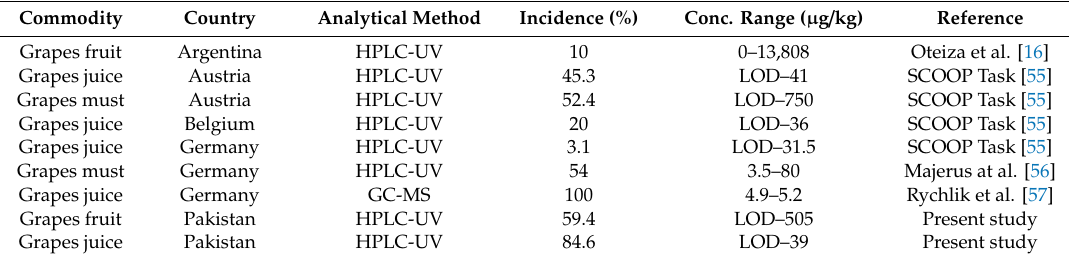
Table 4. A summary of studies on patulin occurrence in grapes fruits and derived